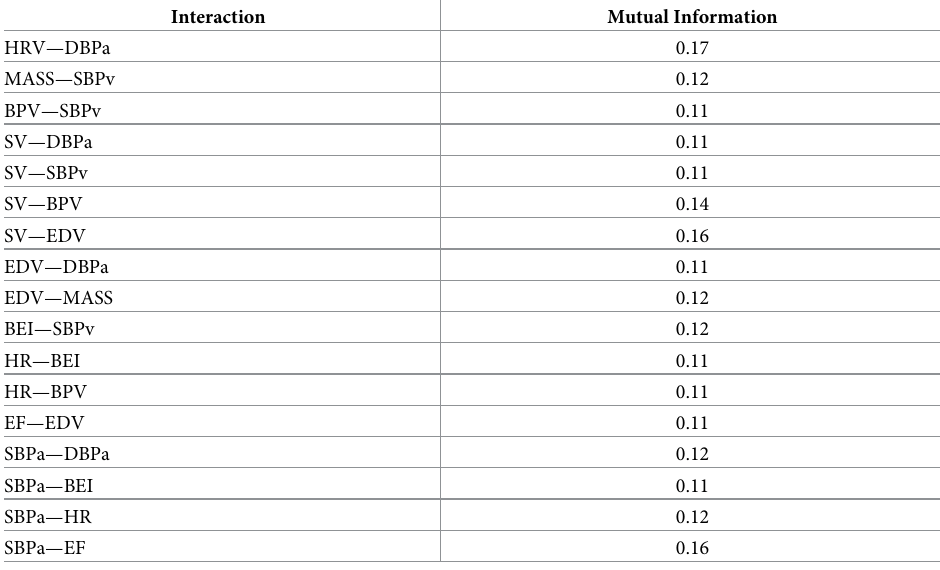
Table 1. Comparison of ANS network diagnostics between CFS and